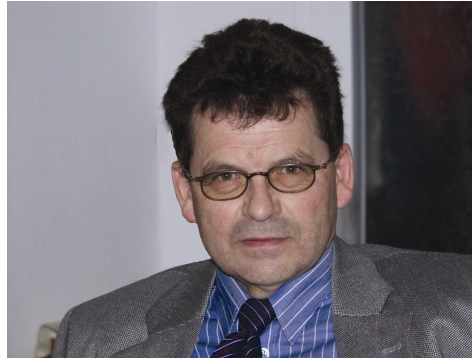
Fig. 1. Professor Oleg